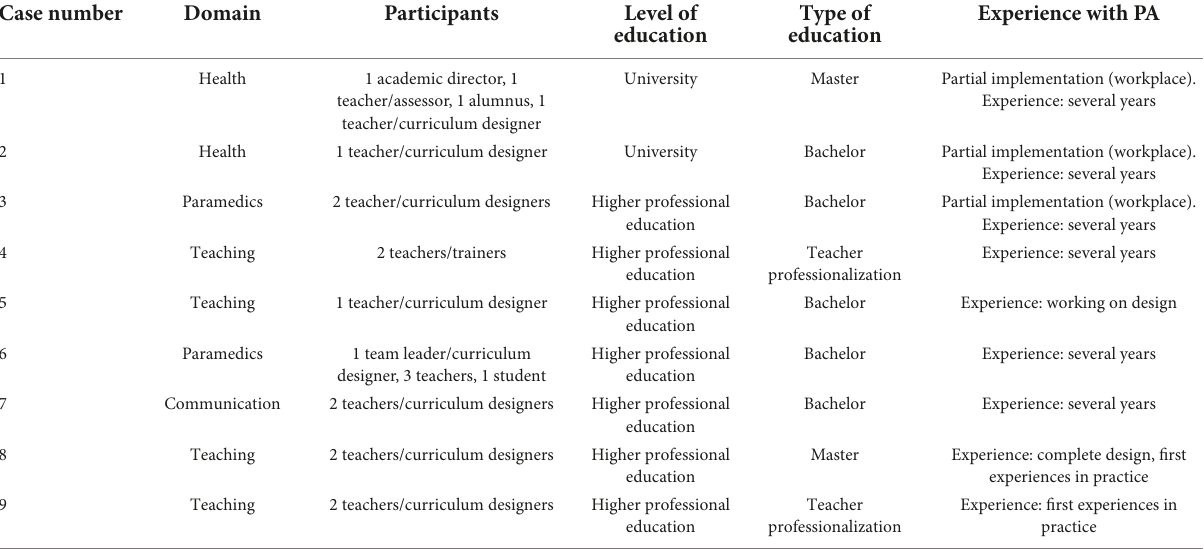
TABLE 2 Overview of higher education programs and